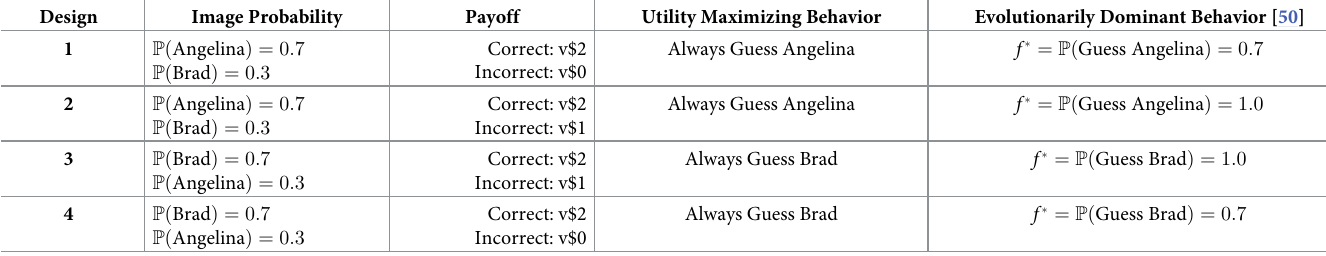
Table 1. Experimental